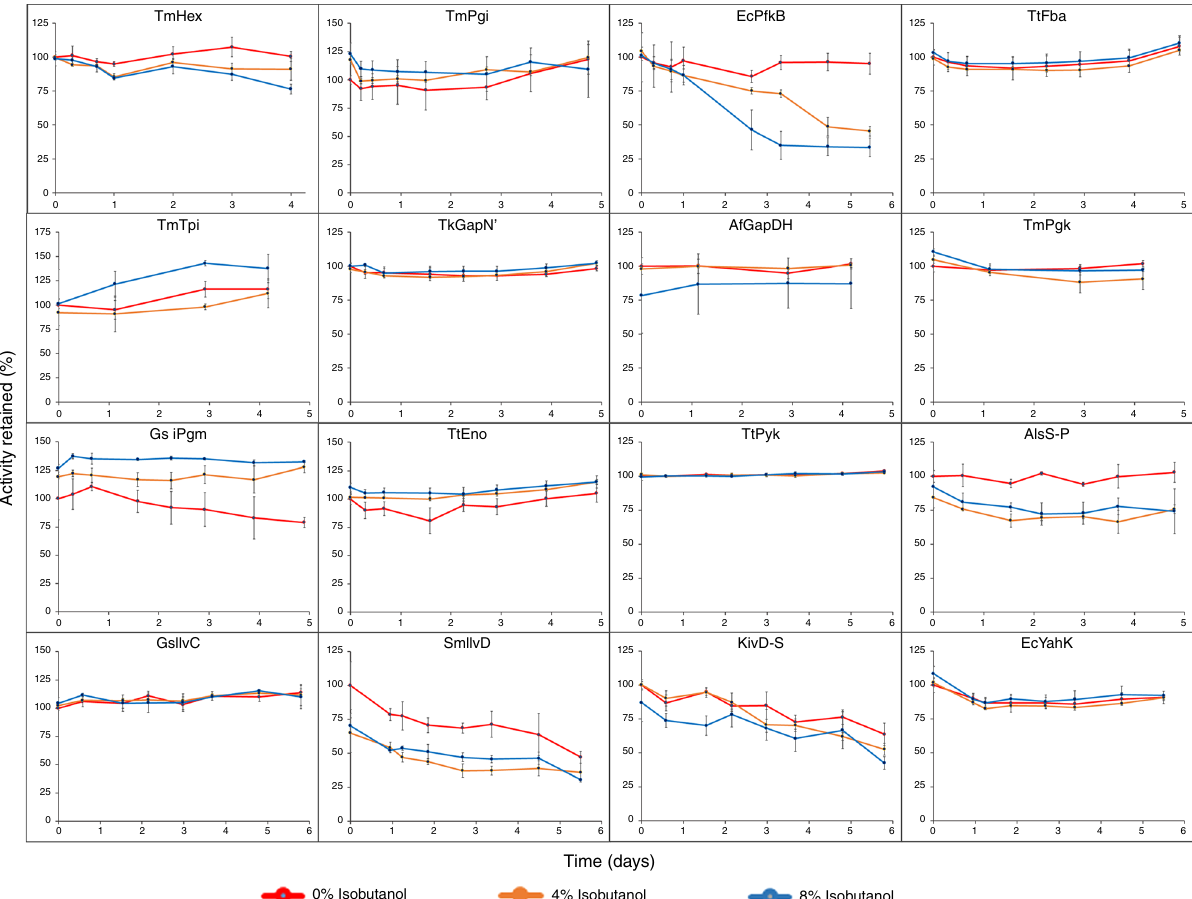
Fig. 2 Isobutanol tolerance of enzymes. The indicated enzymes were incubated at 25°C, in 0% (red), 4% (orange) or 8%(blue) isobutanol. Activity retained is the percentage of the residual activity compared to the initial activity of each enzyme at time zero in 0% isobutanol. The estimated half-life of each enzyme in 8% isobutanol is given in Table 1. Error bars represent the standard deviation of biological triplicates. Source data are provided as a Source data fi